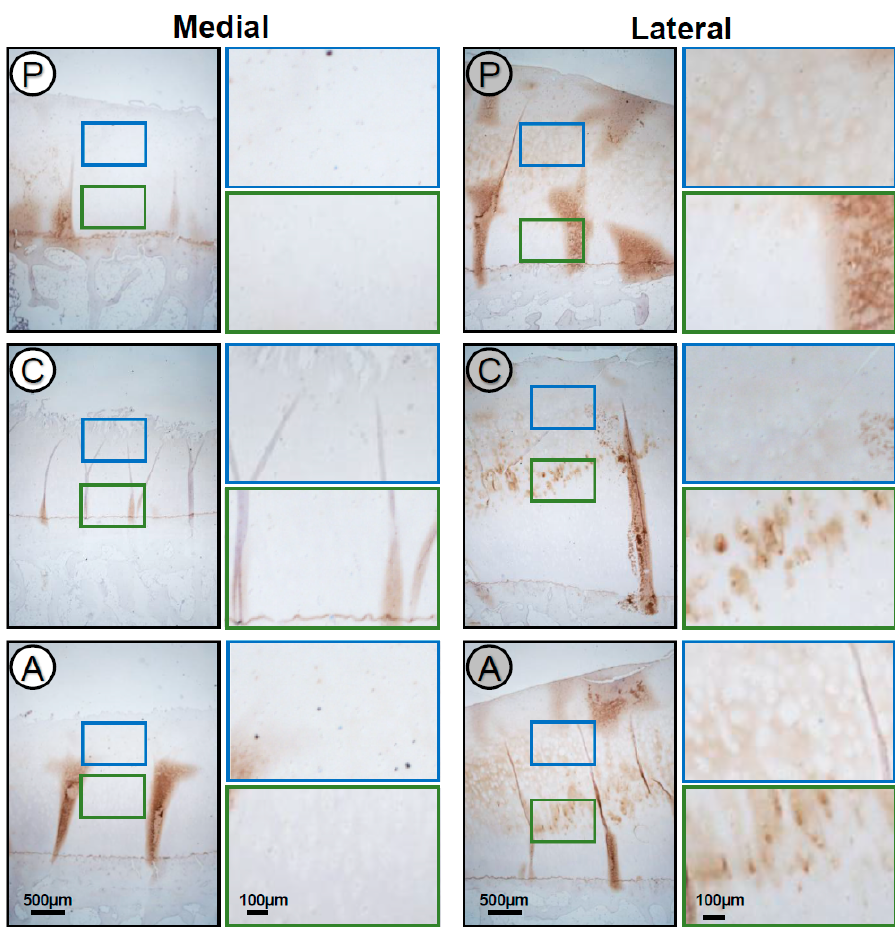
Figure 3. Localization of TSP-1 in the different articular cartilage subregions (A: anterior, C: central, P: posterior) of the medial and lateral tibial compartments. Magnifications of the upper (blue) and deep (green) zone of the subregions. TSP-1 expression was stronger in the cartilage ECM of all subregions from the lateral compartment. Representative TSP-1-stained sections of the different subregions ( n = 12).